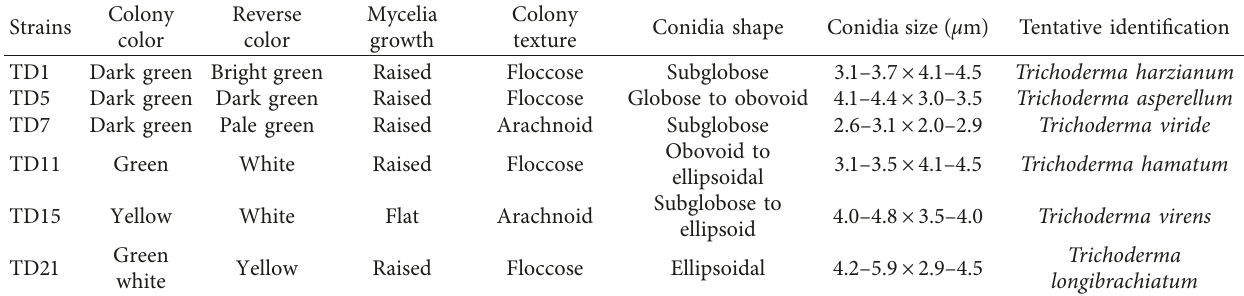
Table 1: Detailed macro- and microcharacteristics of Trichoderma strains isolated from hot pepper rhizospheric soil. Strains